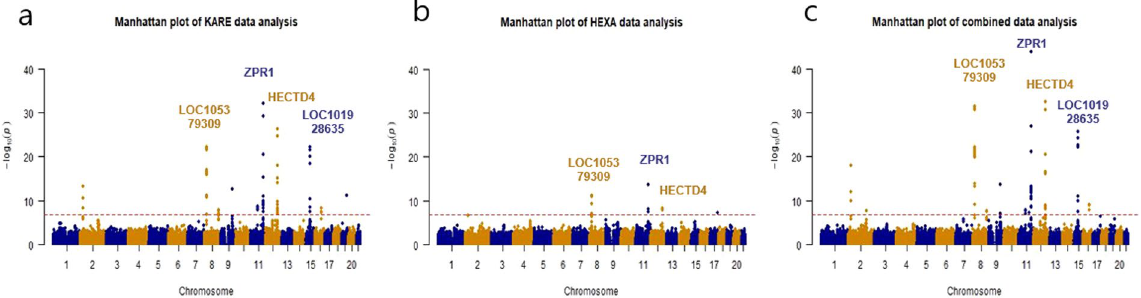
Figure 1. Manhattan plots showing the results of GWAS for MetS: ( a ) KARE, ( b ) HEXA and ( c ) Combined studies.